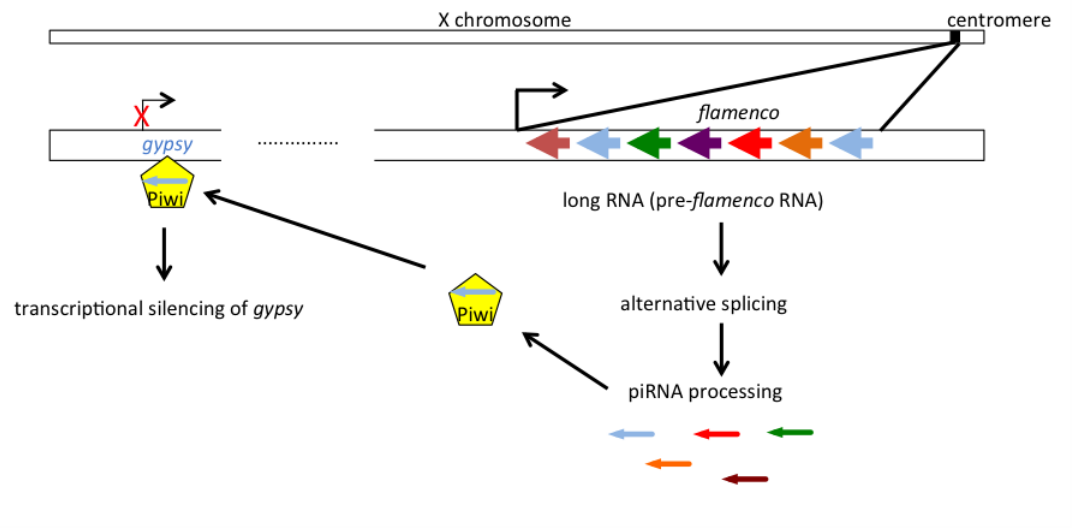
Figure 4. Transcriptional silencing of gypsy by flamenco . The antisense piRNAs are processed from the pre-flamenco RNA (arrows, colors identify truncated errantivirus, blue= gypsy ), then loaded onto Piwi. This piRNA-inducing silencing complex establish a repressive chromatin state on gypsy , inducing transcriptional